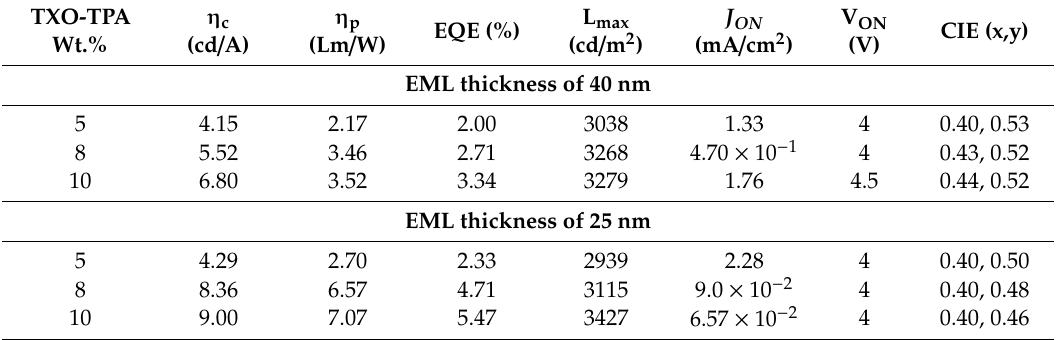
Summary of results obtained for device with structure ITO / PEDOT:PSS (40 nm)